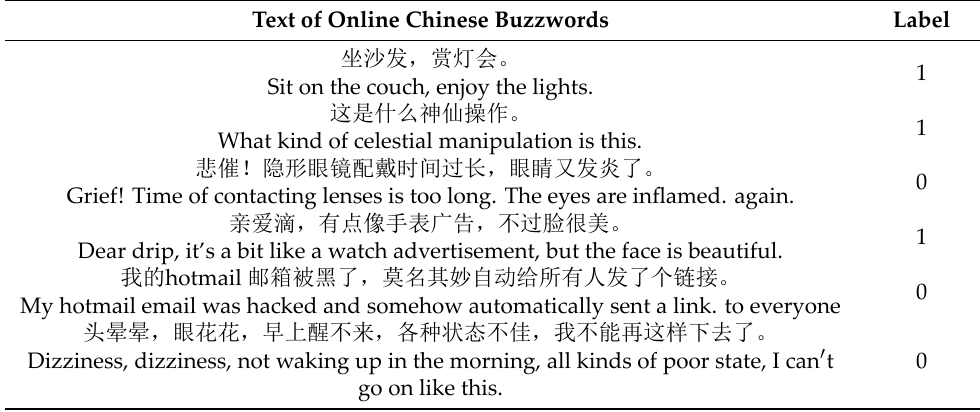
Table 1. Collection of online Chinese buzzwords.